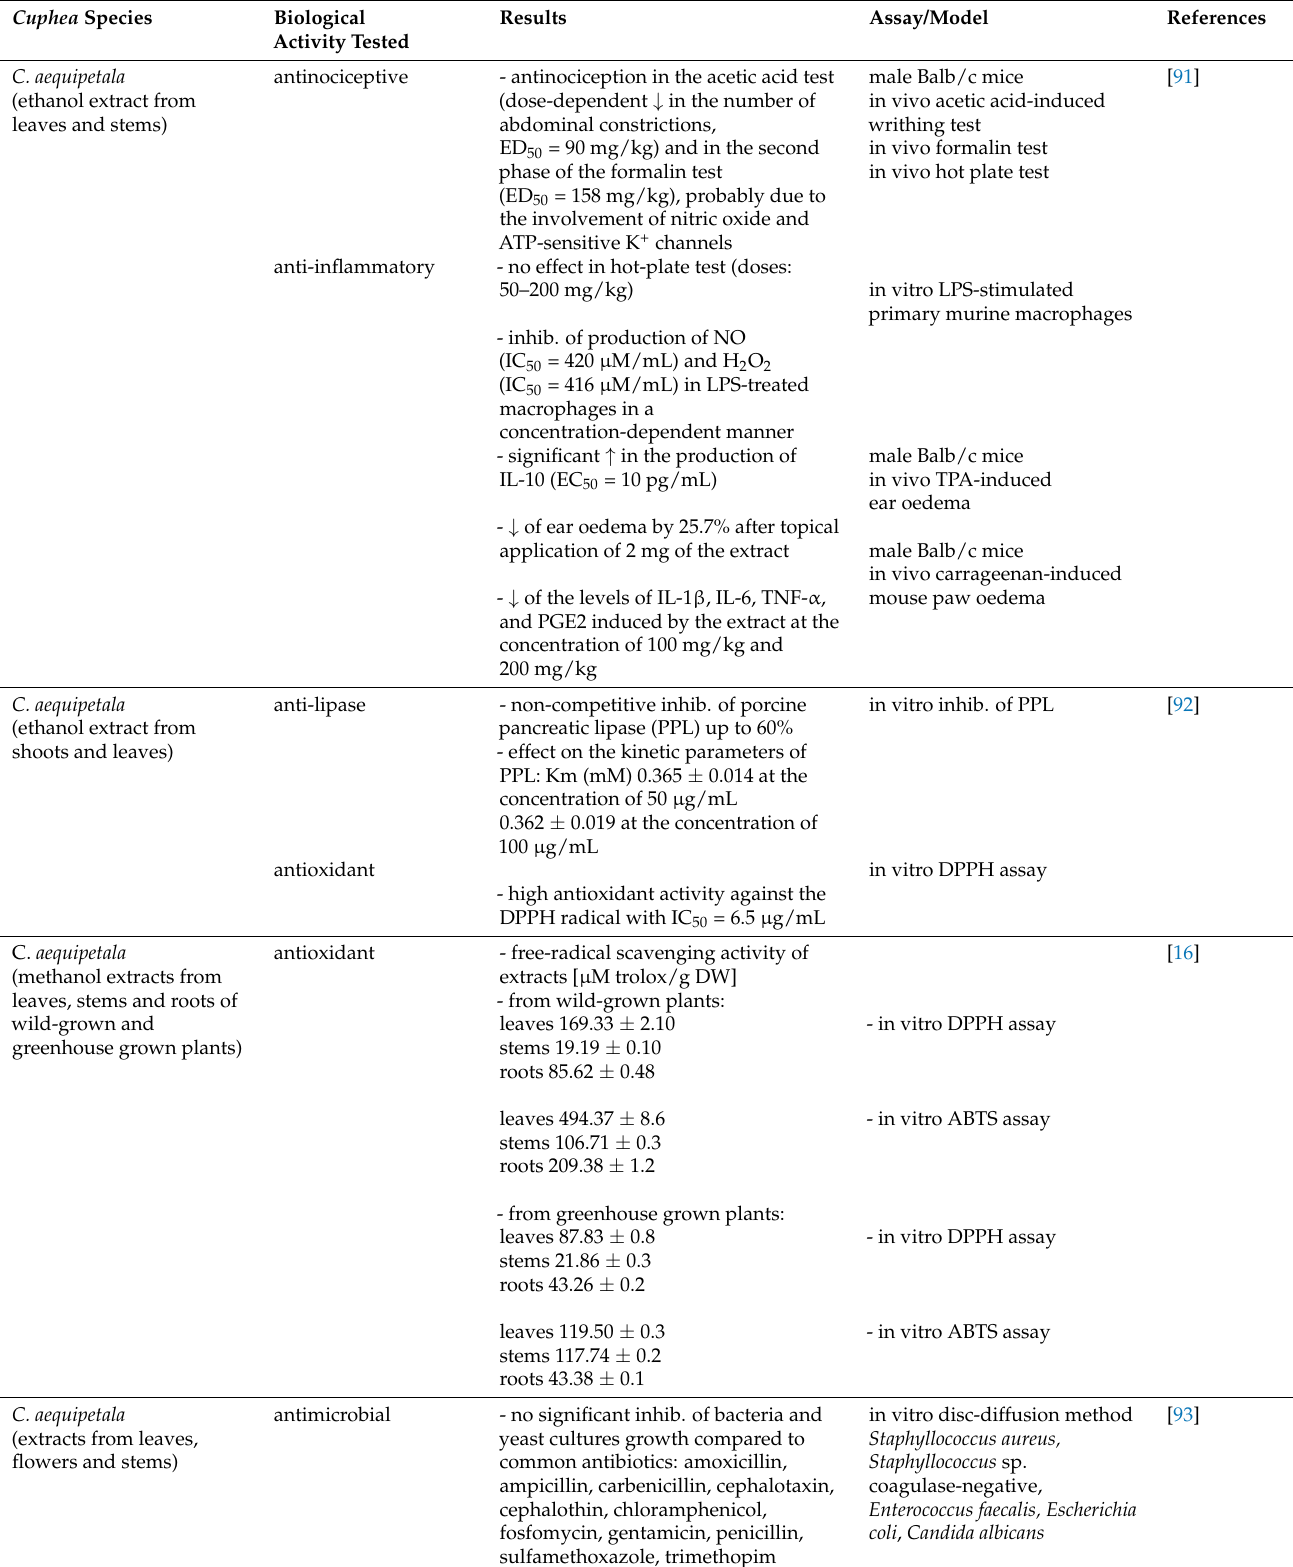
Table 4. The results of pharmacological studies on Cuphea